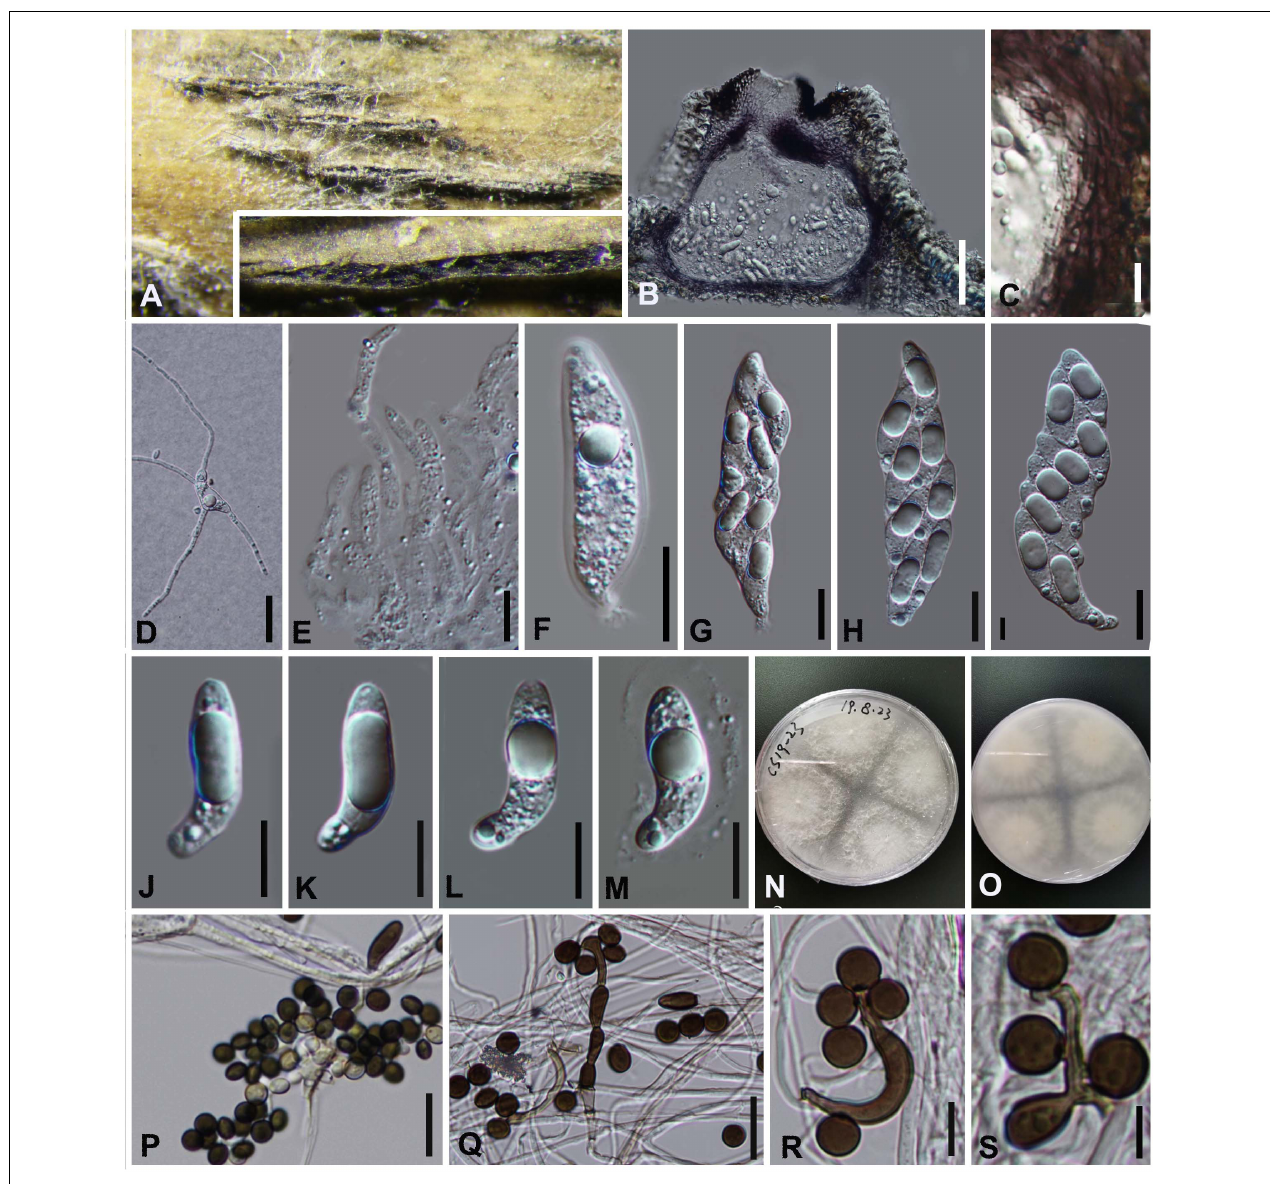
FIGURE 8 | Arthrinium phyllostachium (GZAAS 20–0112) (A) Appearance of stromata on bamboo host. (B) Vertical section of stroma. (C) Peridium. (D) Germinating ascospore. (E) Paraphyses. (F–I) Asci. ( J–M) Ascospore. ( N , O) Culture. (P–S) Conidiogenous cells and conidia. Scale bars: (B) = 50 µ m. (C) = 10 µ m. (D) = 20 µ m. (E) = 20 µ m. (F–I) = 30 µ m. (J–M) = 10 µ m. (P,Q) = 20 µ m. (R–S) = 10 µ